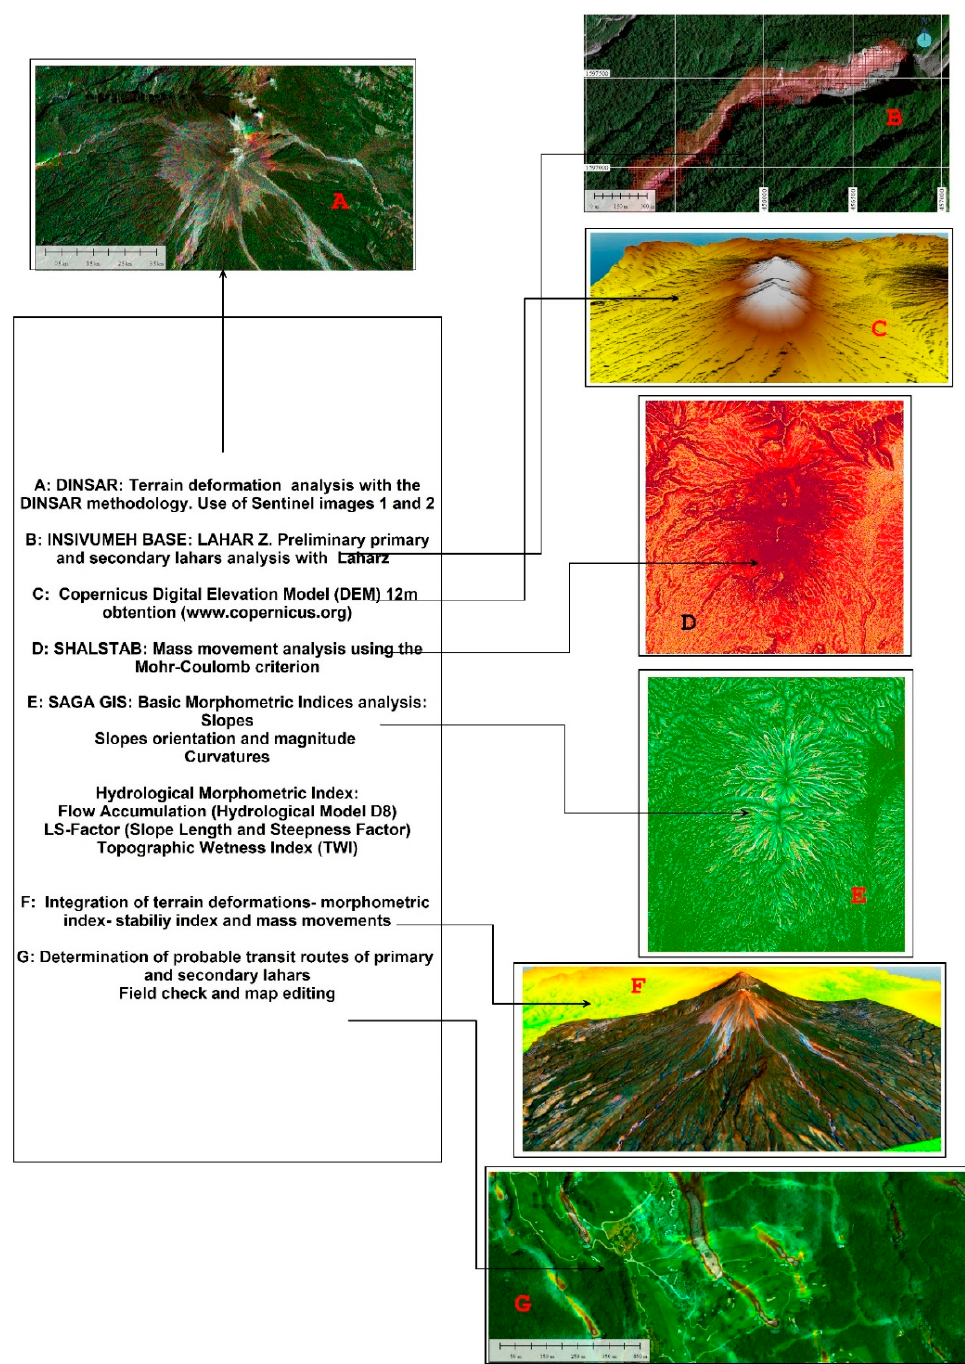
Figure 4. Flow methodological diagram for the determination of primary and secondary lahars flow paths from the following processes: ( A ) Analysis of terrain deformation with differential synthetic aperture radar interferometry DINSAR, ( B ) Use of base information of lahars routes obtained from LAHAR Z -National Institute of Seismology, Volcanology, Meteorology and Hydrology—INSIVUMEHIN. ( C ) Obtaining the digital elevation model of 12m of spatial resolution of Copernicus.org, ( D ) Analysis of Instability of the Relief with Shallow Landslide Susceptibility software (SHALSTAB), ( E ) Determination of Morphometric Indexes of the Relief with System for Automated Geoscientific Analyzes (SAGA), ( F ) Integration of information and determination of possible flow paths of primary and secondary lahars ( G ).